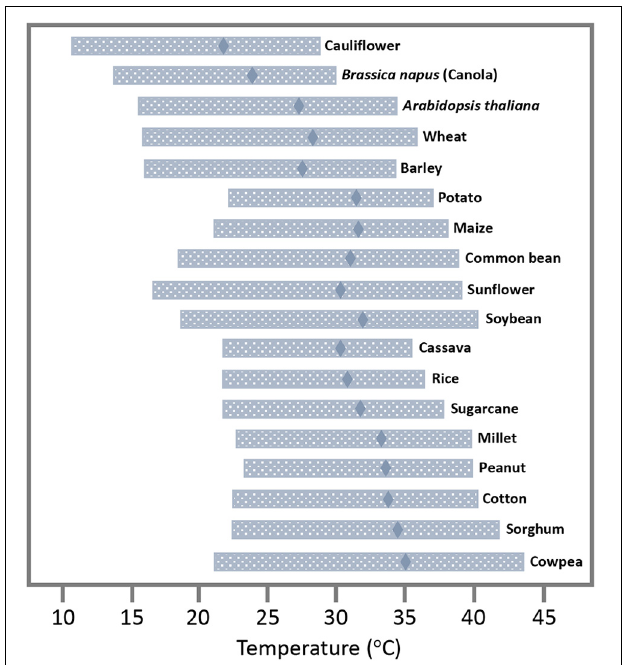
FIGURE 1 | Temperature tolerance range of plant and crop species. Temperature optimum at which plant development has its maximum rate (diamonds) and range of temperature for which the rate of development is at least 50% of its maximum (horizontal bars). Adapted from Parent and Tardieu (2012), with permission by the